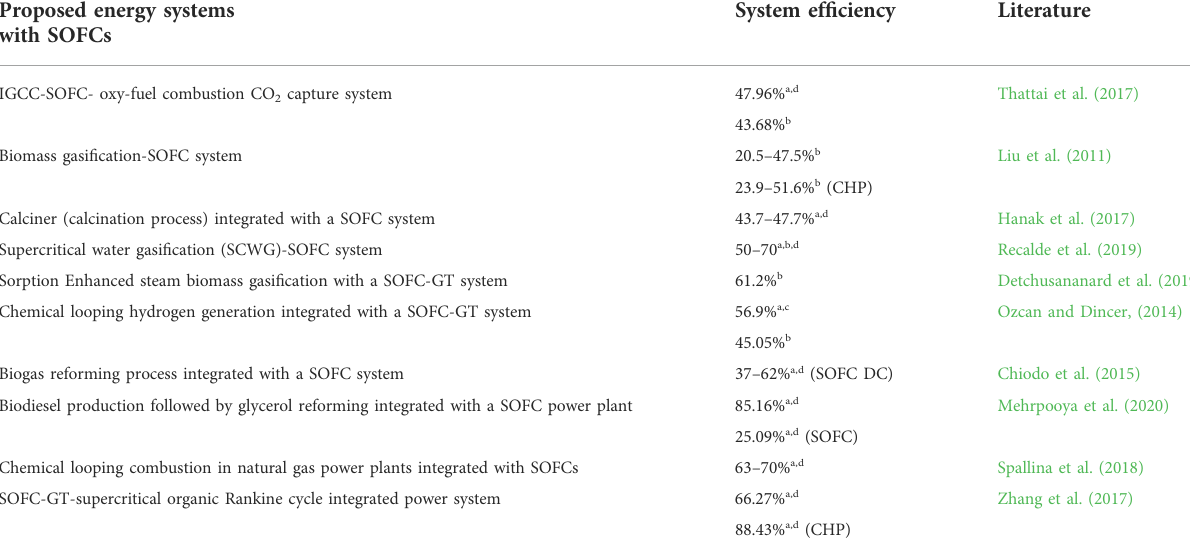
TABLE 1 State-of-art of the researches on various energy systems integrated with